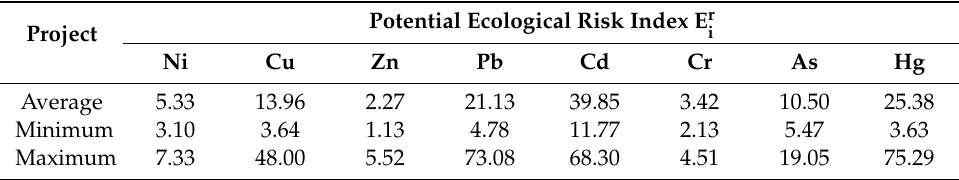
Table 4. Potential ecological risk assessment results of heavy metals in sediments of the Three Gorges Reservoir.